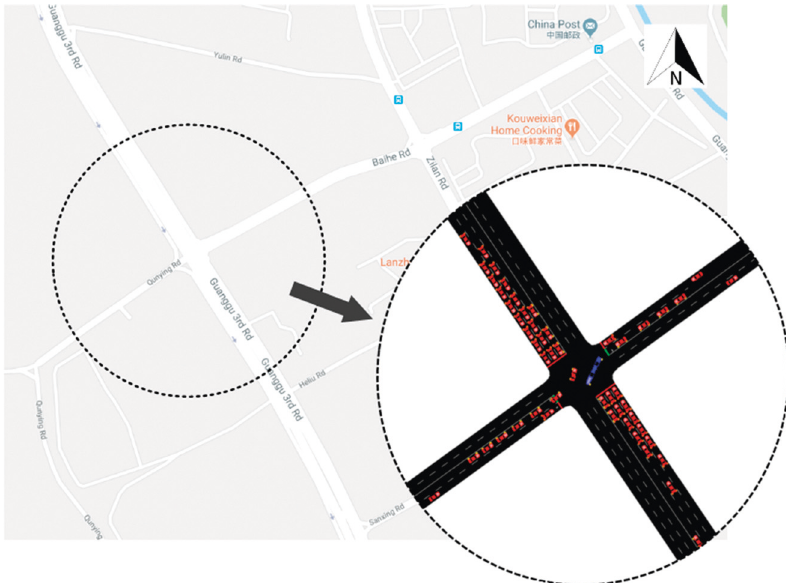
Figure 1: Intersection structure diagram.